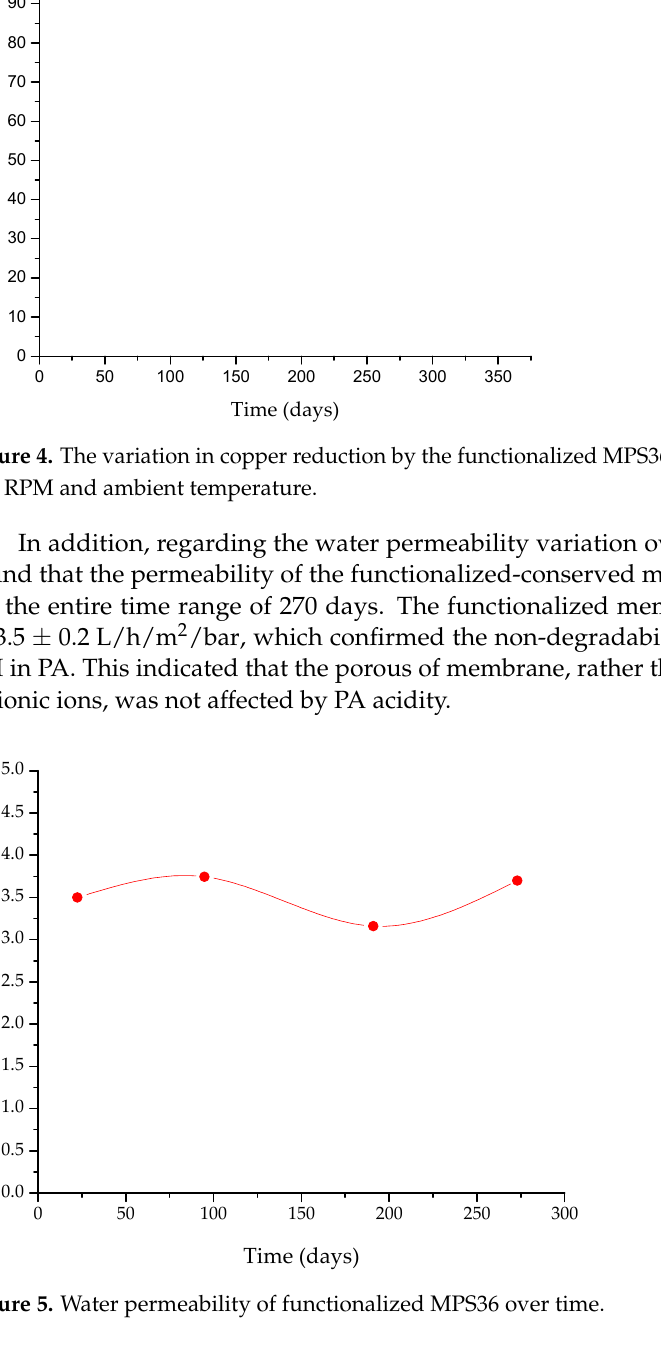
Figure 3. The permeability variation of MPS36 and functionalized MPS36 versus the factor of volume reduction (FVR).